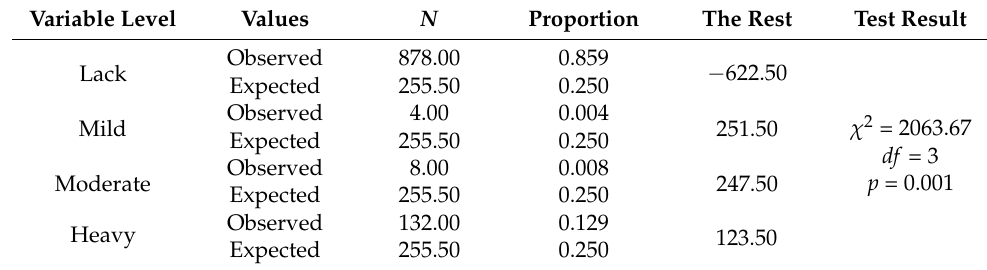
Table 3. Assessment of the occurrence of “food